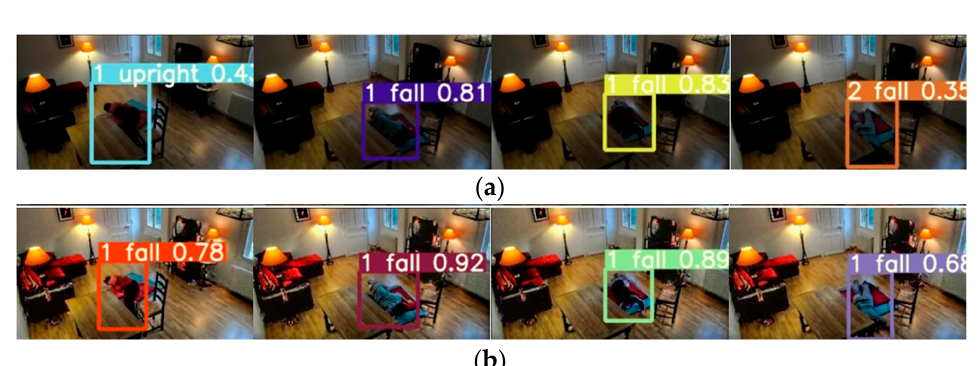
Figure 5. Visual results of object tracking on Le2i Fall Detection dataset. ( a ) YOLOv7 + Deep SORT method. ( b ) The proposed method.